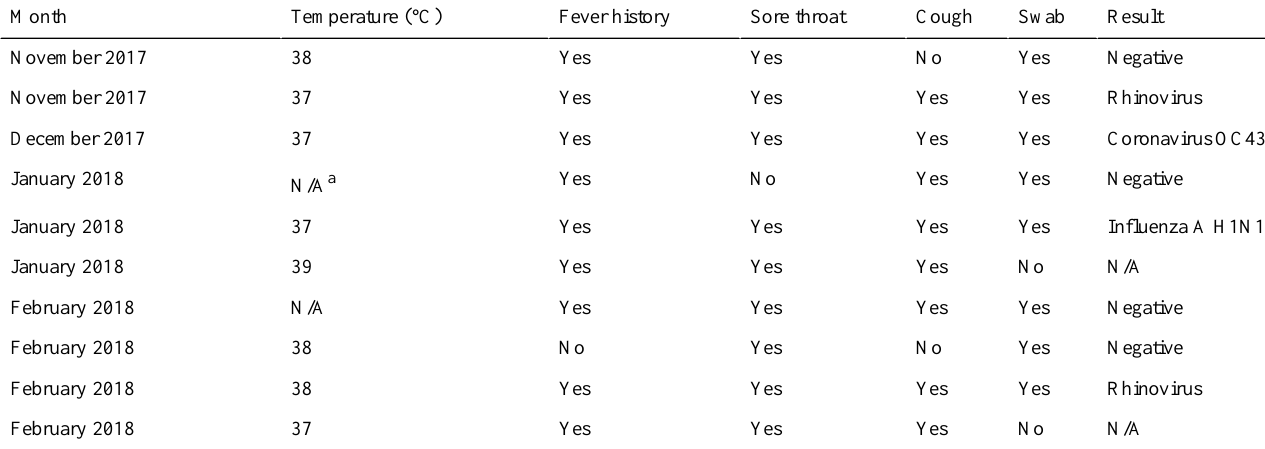
Table 1. Clinical characteristics and swab results of 10 influenza-like illness episodes reported by practice staff.